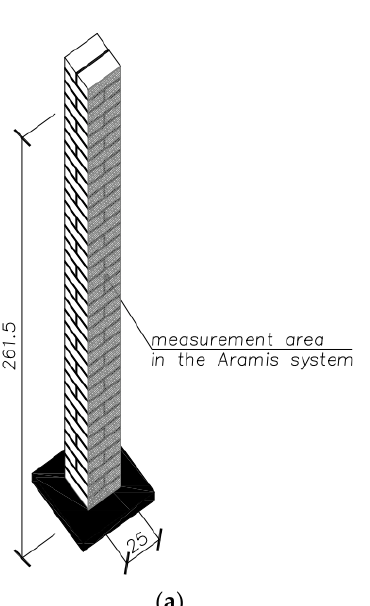
Figure 18. Stress-strain under compression relationship of clay brick pillars under uniform load and view of an example element after the test [23].